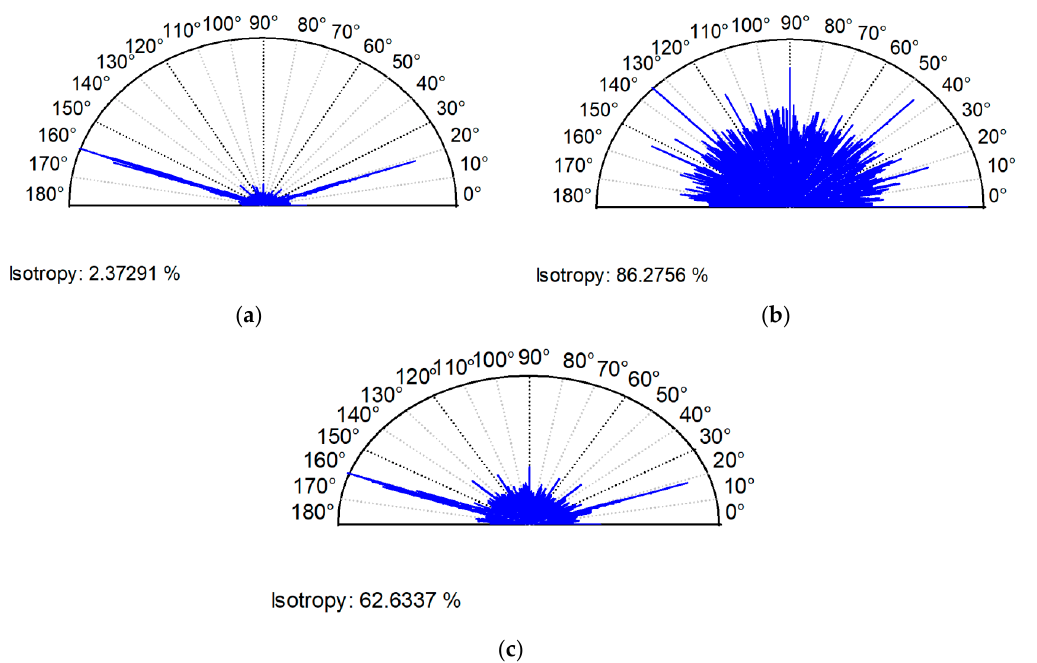
Figure 12. Directionality plots of surface E ( a ), of surface F ( b ), and of equivalent sum surface ( c ). Materials 2020 , 13 , x FOR PEER REVIEW When isotropic one-process surface G was added to isotropic two-process surface H (Figure 13), the errors of predictions of most parameters (Sq, Sdq, Sds, Str, and Sal) were comparatively low (smaller than 4.5%)—Table 6. However, relative differences among real and predicted parameters describing shapes of the ordinate distributions of analyzed textures were larger (Figure 14). The predicted Ssk parameter was underestimated (the error was near 50%), while the Sku parameter was overestimated. The errors of parameters Sp/Sz and Sq/Sa predictions were smaller and amounted to 11% and 6%, respectively. Table 6. Selected parameters of surface G, of surface H, of the sum surface, and of predicted parameters of the sum surface.